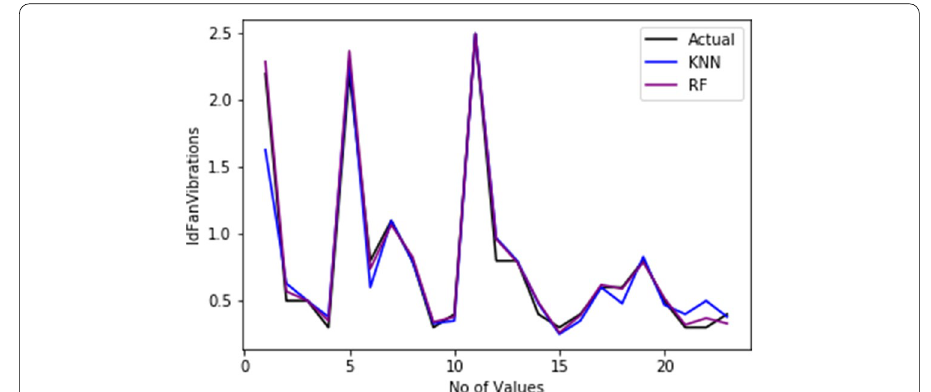
Fig. 4 Comparison of KNN and RF imputed and actual values at 15% on the Id fan